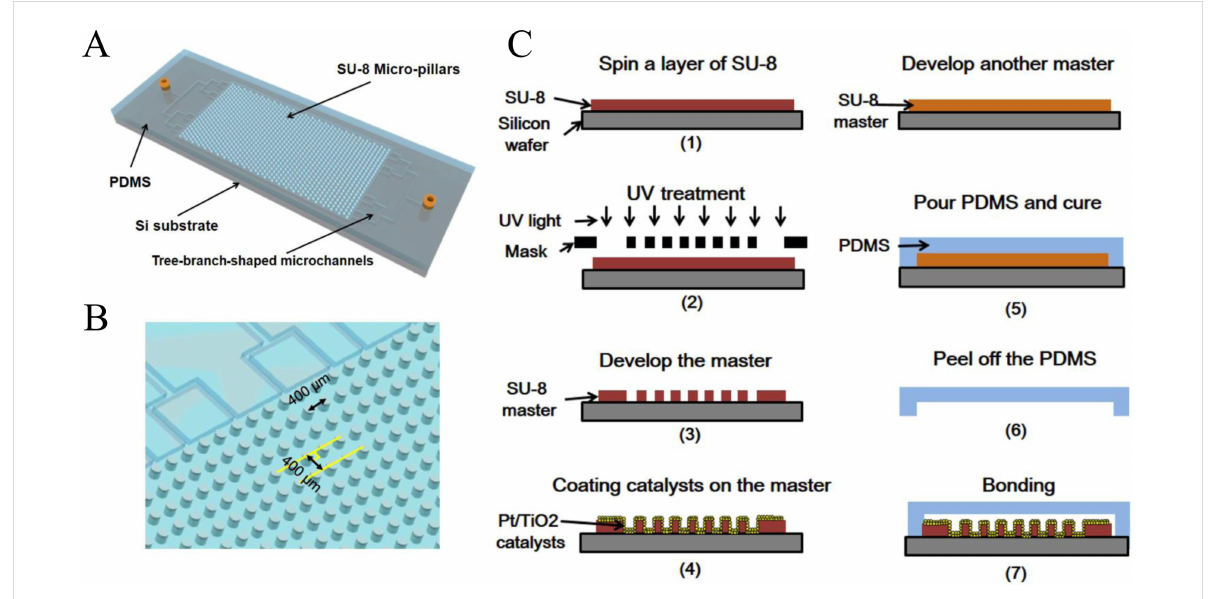
Figure 4: (A) Schematic of the high-surface-area optofluidic microreactor with micropillar structure. (B) Staggered micropillars in the reaction chamber. (C) Fabrication procedure of the optofluidic microreactor with the catalyst-coated micropillars. Reprint with the permission from [74], copy- right 2014 Elsevier Ltd.